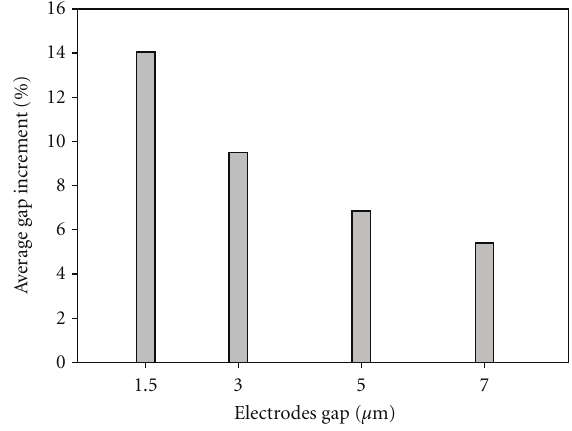
Figure 12: Voltages and the corresponding deflection and capaci- tance values.